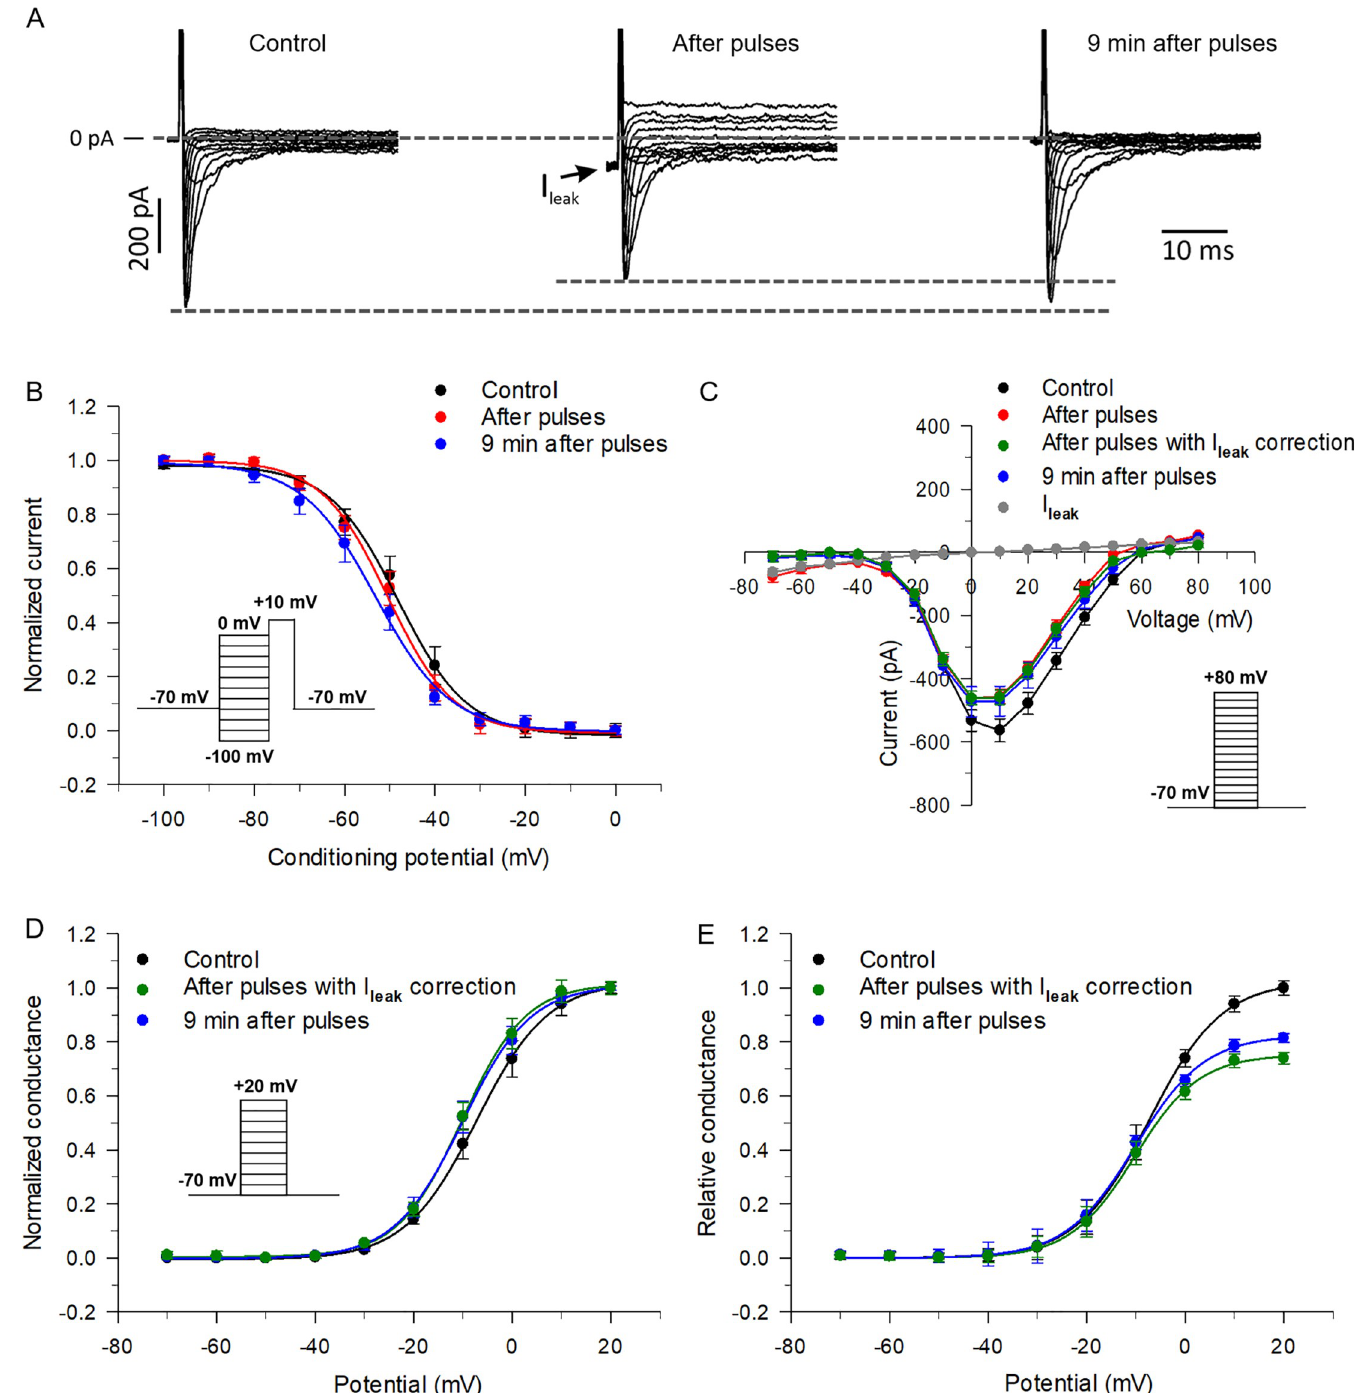
Fig 8. Effects of twin NEPs applied with a 1 s time interval on the voltage-dependence of steady-state inactivation, activation and conductance of I Na at an E-field of 8 MV/m. (A) Three families of I Na recorded in the same cell from a typical experiment; as depicted, these families of traces were recorded before (Control; left traces), immediately after (After pulses; middle traces) and 9 min after (right traces) twin pulse exposure. For each family of traces, step potentials spanned from –40 to +60 mV. (B) Steady-state inactivation curves of I Na recorded before (control, black circles), right after (red circles) and 9 min after (blue circles) twin pulse exposure. I Na in each case was normalized to its respective maximal value, plotted as a function of the conditioning potential and fitted to a Boltzmann function (solid lines). The data represent the mean value ± SE, n = 5. The V 0.5 and slope factor values derived from all Boltzmann fits can be found in the text. Overall One-Way ANOVA yielded P values for V 0.5 (P = 0.24373) and k (P = 0.8831) that revealed no significant differences between the means of the three groups. (C) I-V relationships recorded before